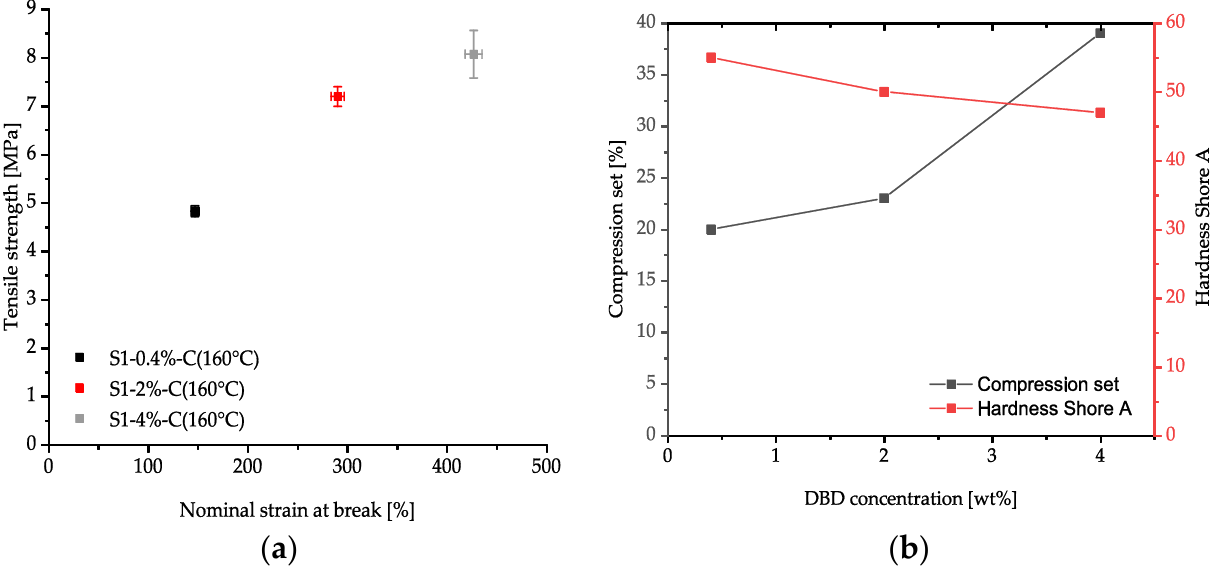
Figure 3. Tensile strength and nominal strain at break ( a ) and compression set and hardness Shore A ( b ) of S1-0.4%-C (160 °C), S1-2%-C (160 °C), and S1-4%-C (160 °C).